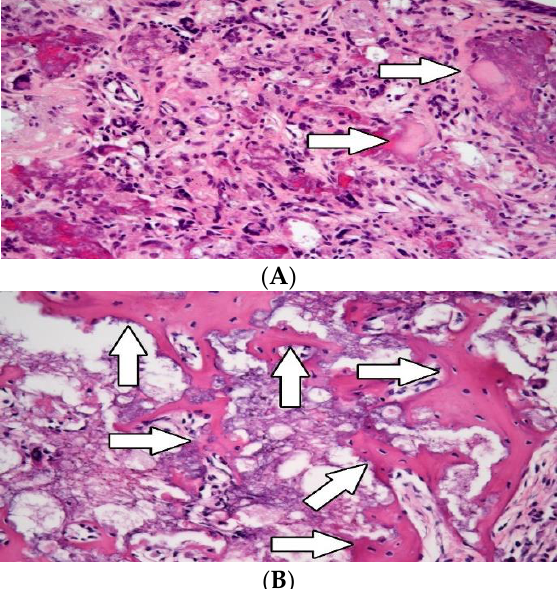
Figure 2. Histological examination of the tympanic bulla. The hydroxyapatite was seen in the tissue as a foreign material (white arrows) bubbly violet in direct contact with newly formed trabeculae of immature materiale woven bone. Compare the amount of newly formed woven bone between group A (without application of CsA; ( A )) and group B (with application of CsA; ( B ))—white arrows. Hematoxylin-eosin, original magnification 400×.